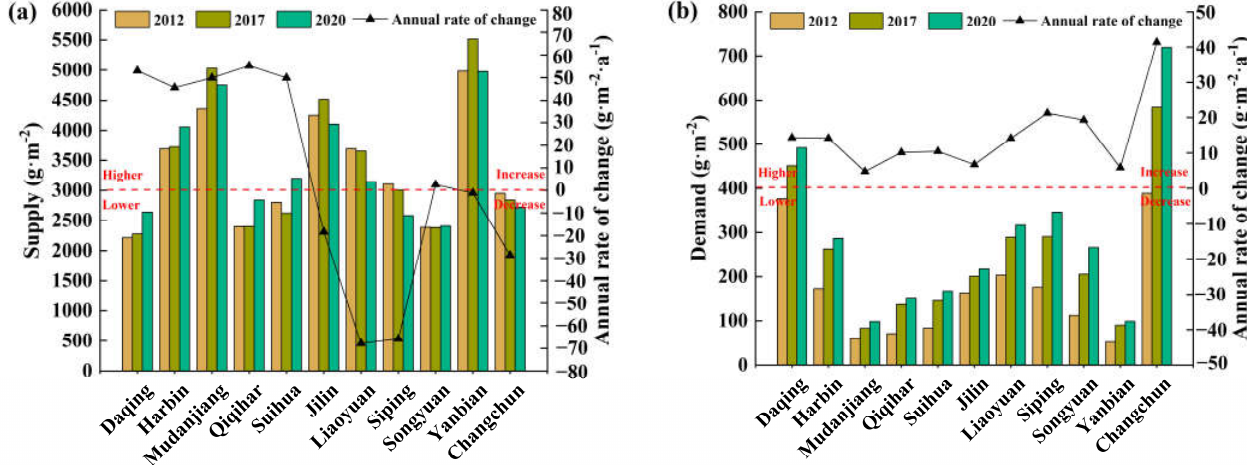
Figure 6. Supply ( a ) and demand ( b ) and their annual rate of change in each city.